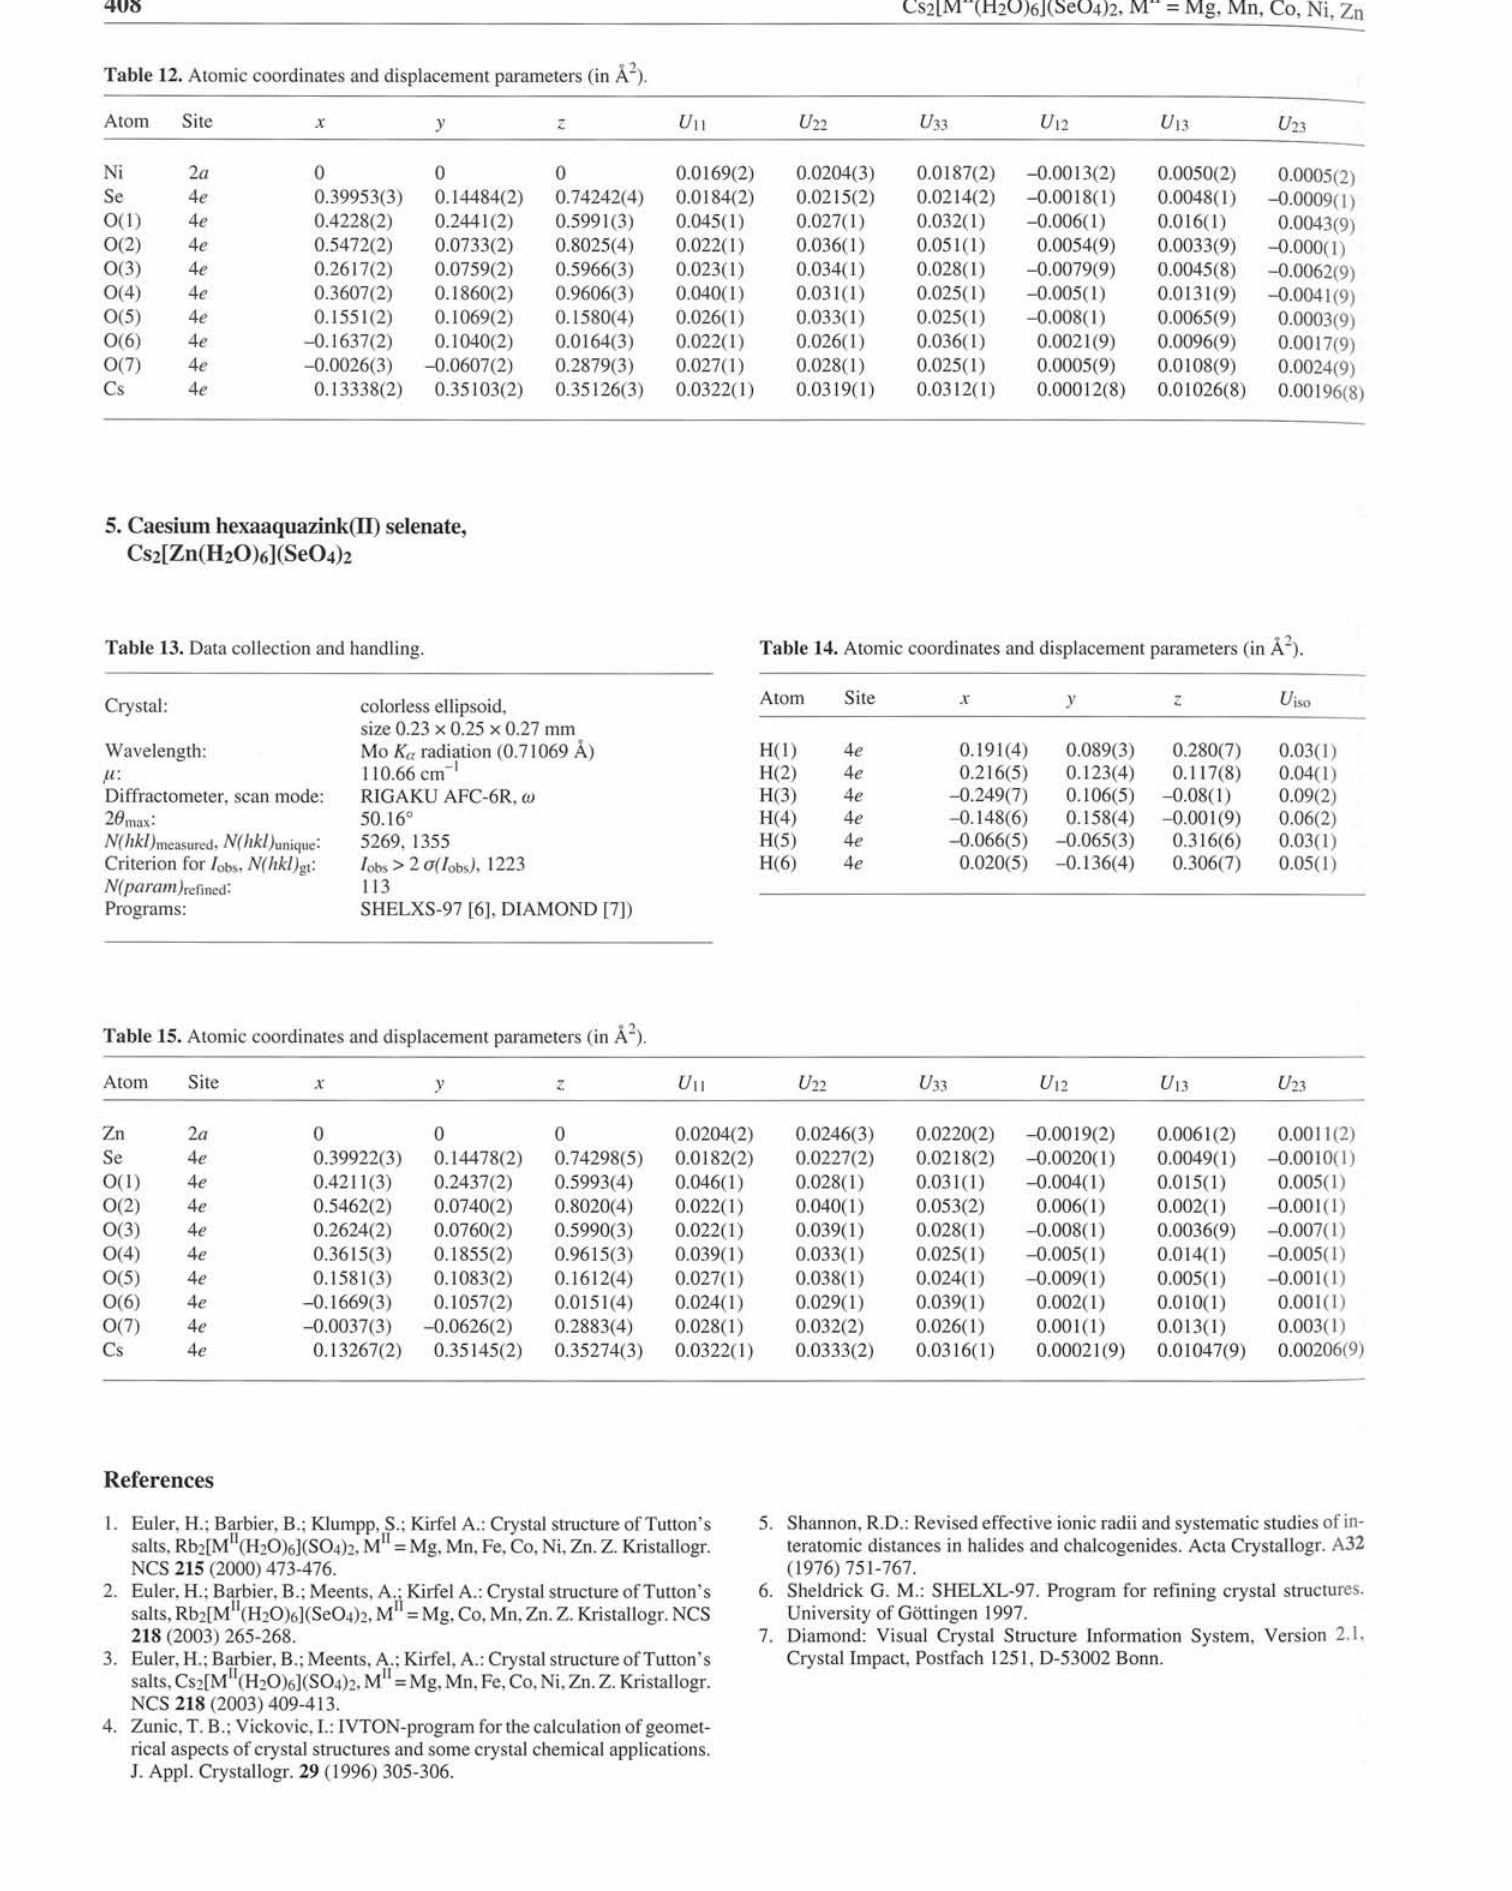
Table 13. Data collection and handling. Table 14. Atomic coordinates and displacement parameters (in Â 2 ).